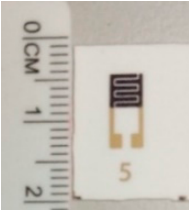
Figure 2. Fabricated TiO 2 -B 2 O 3 gas sensor on alumina substrate using a screen-printing method.